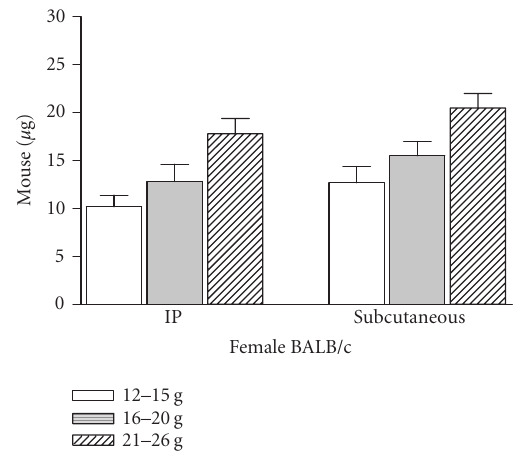
Figure 1: E ff ects of CSV toxicity according to mouse sex. Groups of female mice from di ff erent strains, 16–20 g of body weight, were injected intraperitoneally or subcutaneously with di ff erent amounts of CSV. The LD 50 value was calculated by probit analysis of the death occurring within 24 h of venom injection. The experiment was re- peated twice and each point represents the values of pooled sera SD. from 5 animals (cid:0)